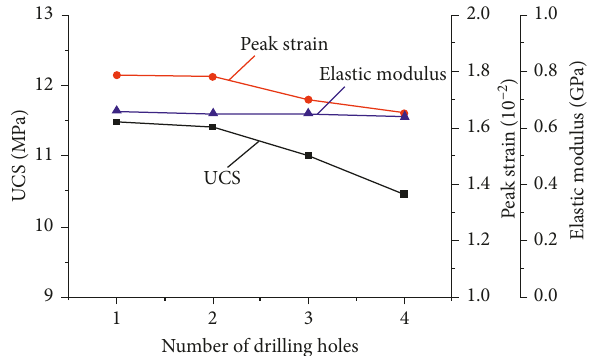
Figure 7: Influence of number of drilling holes in one row on the mechanical properties of specimens.